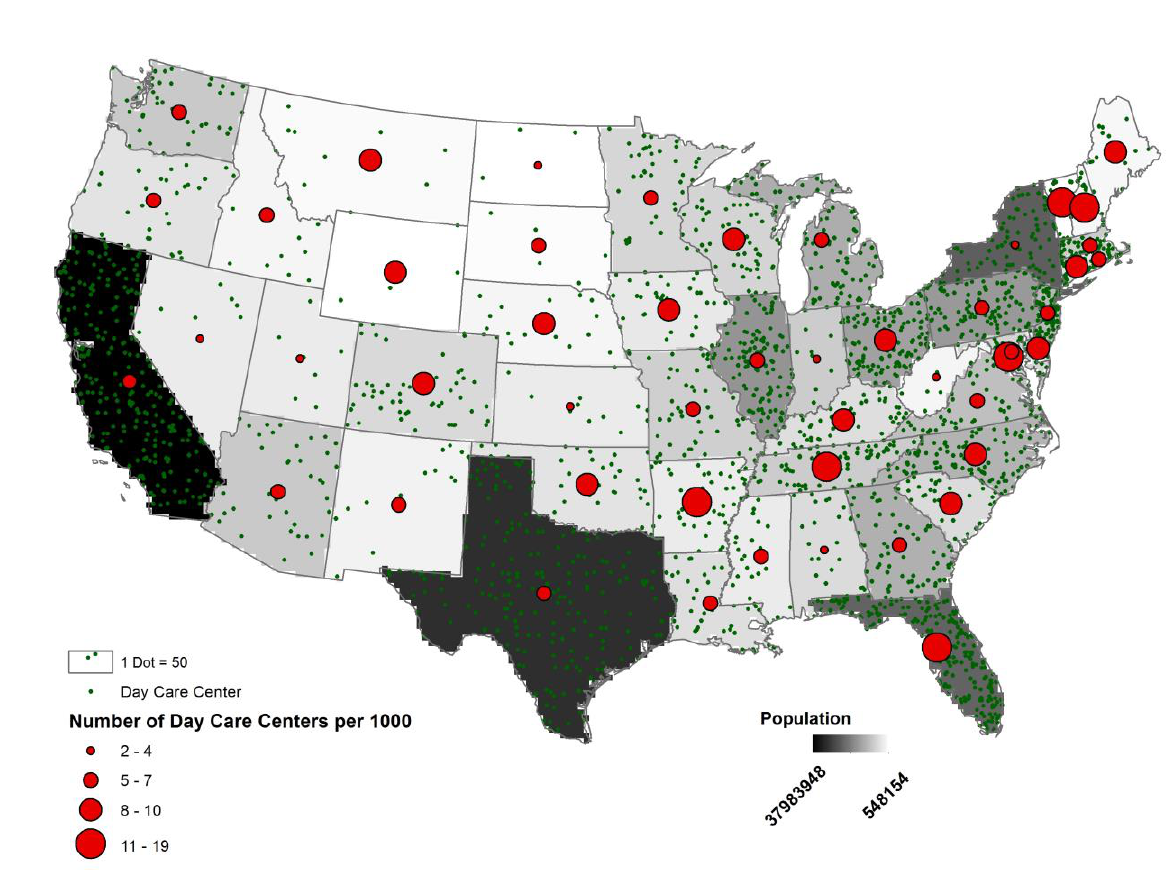
Figure 2. Number and proportion of day care centers by state as compared to population